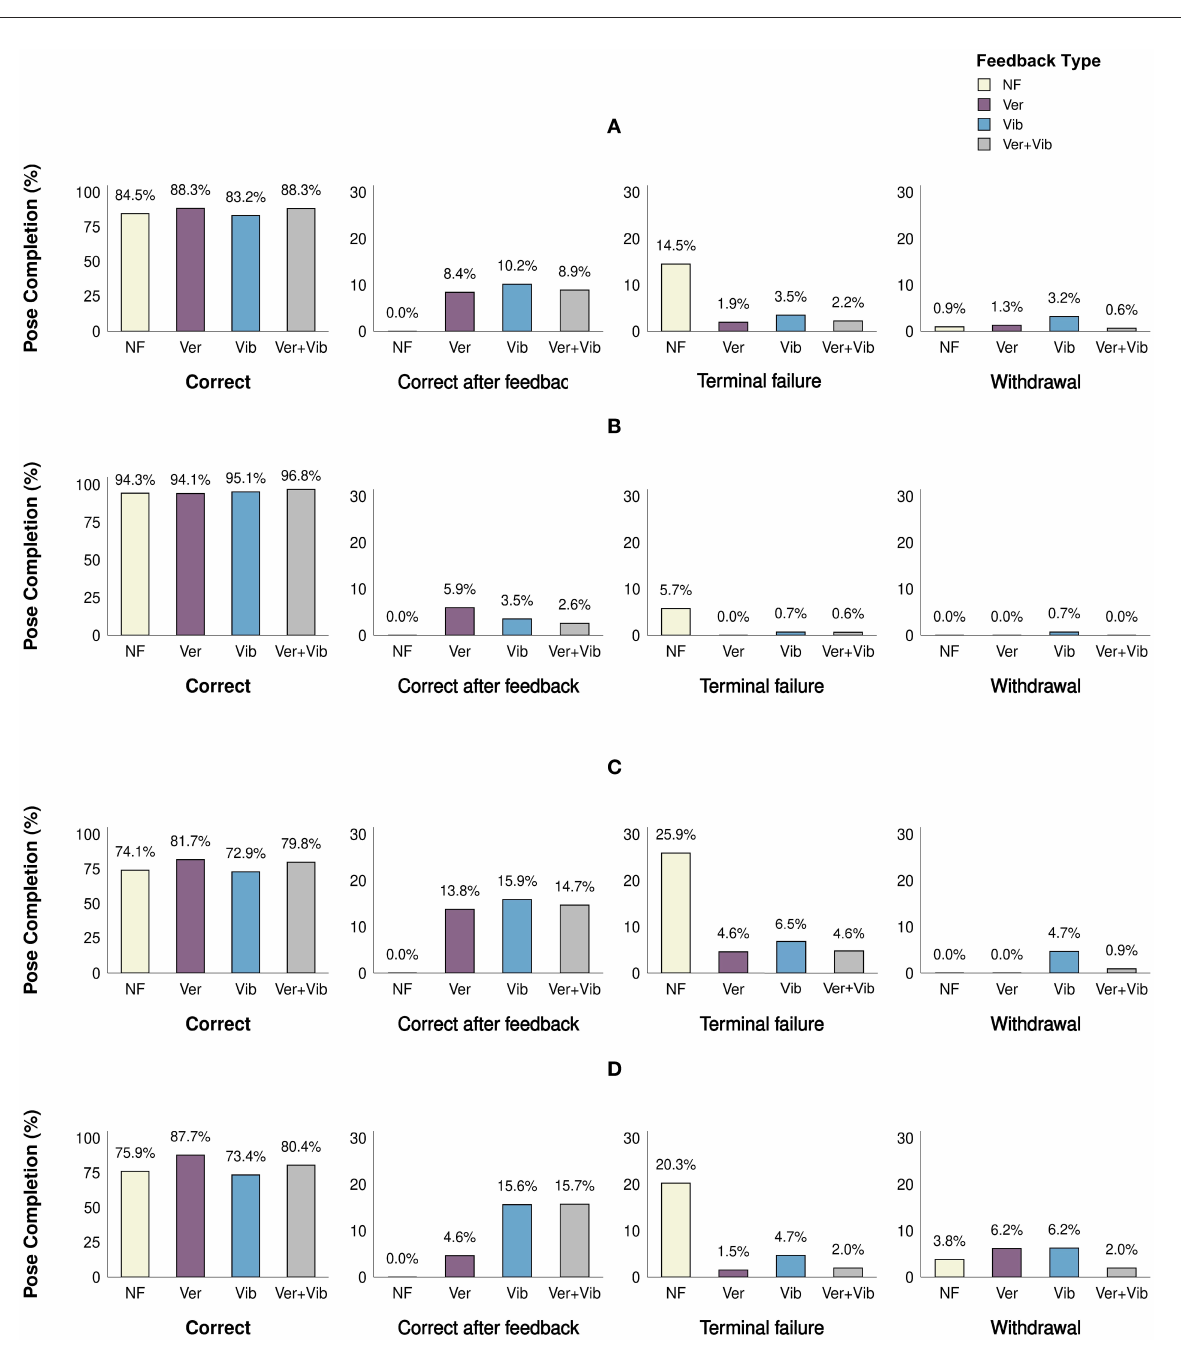
(FsMe and FeMs) by feedback type and pose difficulty level, separately. Average time measures across all poses were 10.0 ± 5.0 s for FsMe and − 5.1 ± 5.3 s for FeMs. Two-way ANOVAs showed statistically significant differences in FsMe among feedback types [ F (2,227) =